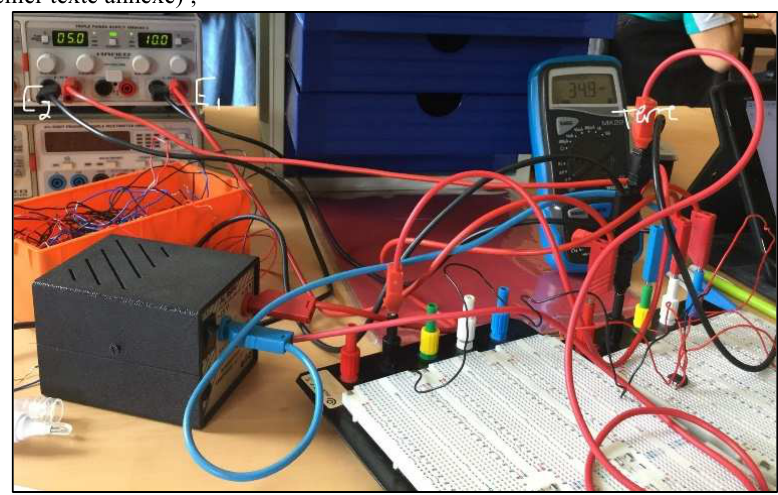
Figure 2. Annotations (E 2 et Terre) d’une photographie d’un montage expérimental.